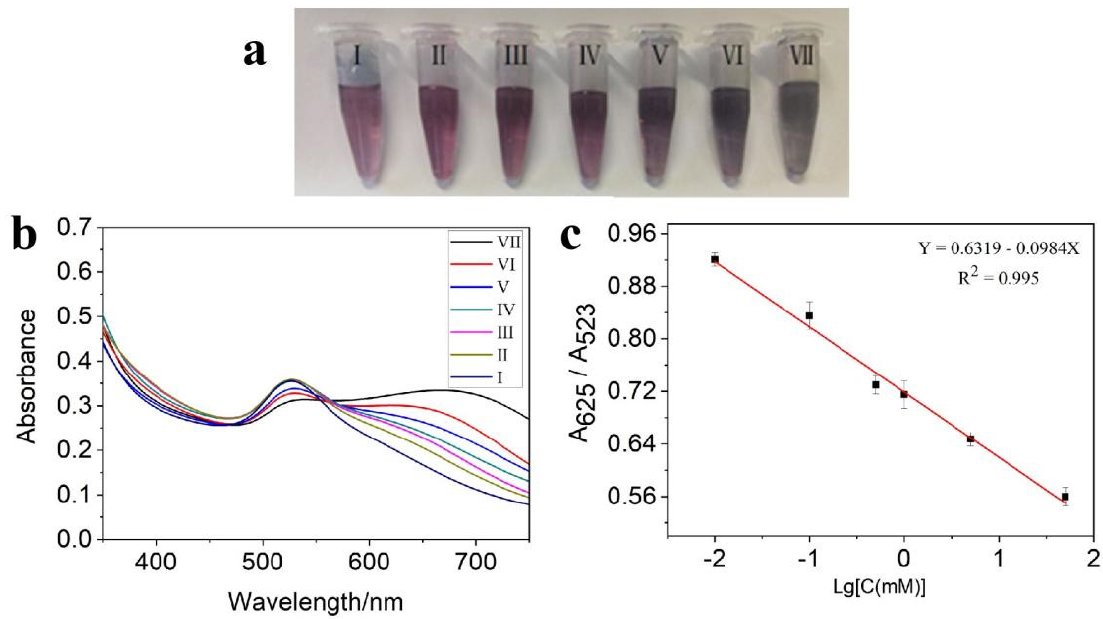
Figure 7. ( a ) Photographs showing the colorimetric detection of glucose with the naked eye: (I) 5 mM, (II) 0.5 mM, (III) 0.1 mM, (IV) 0.05 mM, (V) 0.01 mM, (VI) 0.001 mM, and (VII) 0. ( b ) UV − vis absorption spectra change corresponding with ( a ). ( c ) The linear fitted curve presenting the absorbance ratio of A 625 /A 523 at different concentrations of glucose; error bars indicate S ( n = 3). Table 2. Comparison of this work with other methods for glucose detection.